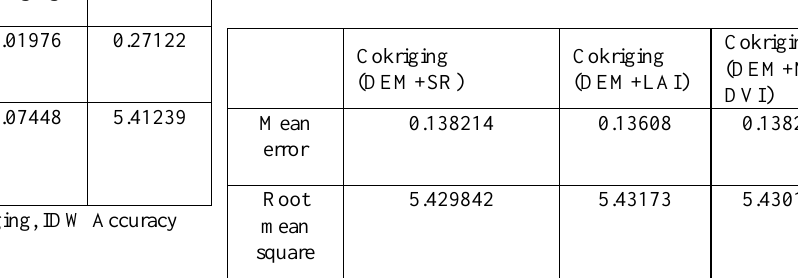
Figure7. Cokriging(DEM+SR), Cokriging(DEM+NDVI),